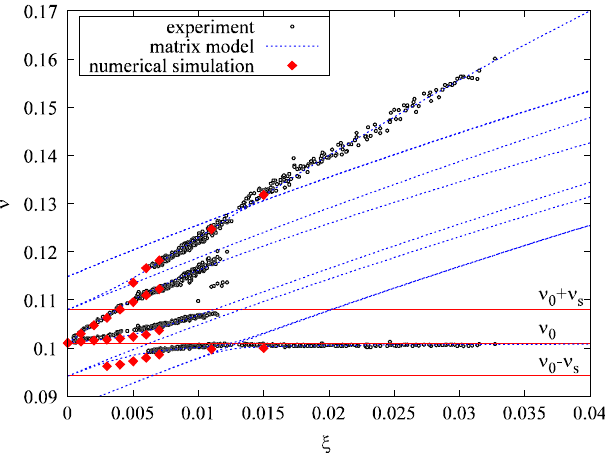
FIG. 2. (Color) The points show the tunes of experimentally observed synchrobetatron modes at the VEPP-2M accelerator. The red diamonds show the tunes of simulated synchrobetatron modes as a function of beam-beam parameter (cid:9) . The dashed lines show the evolution of mode frequencies predicted by the matrix model as described in the text.